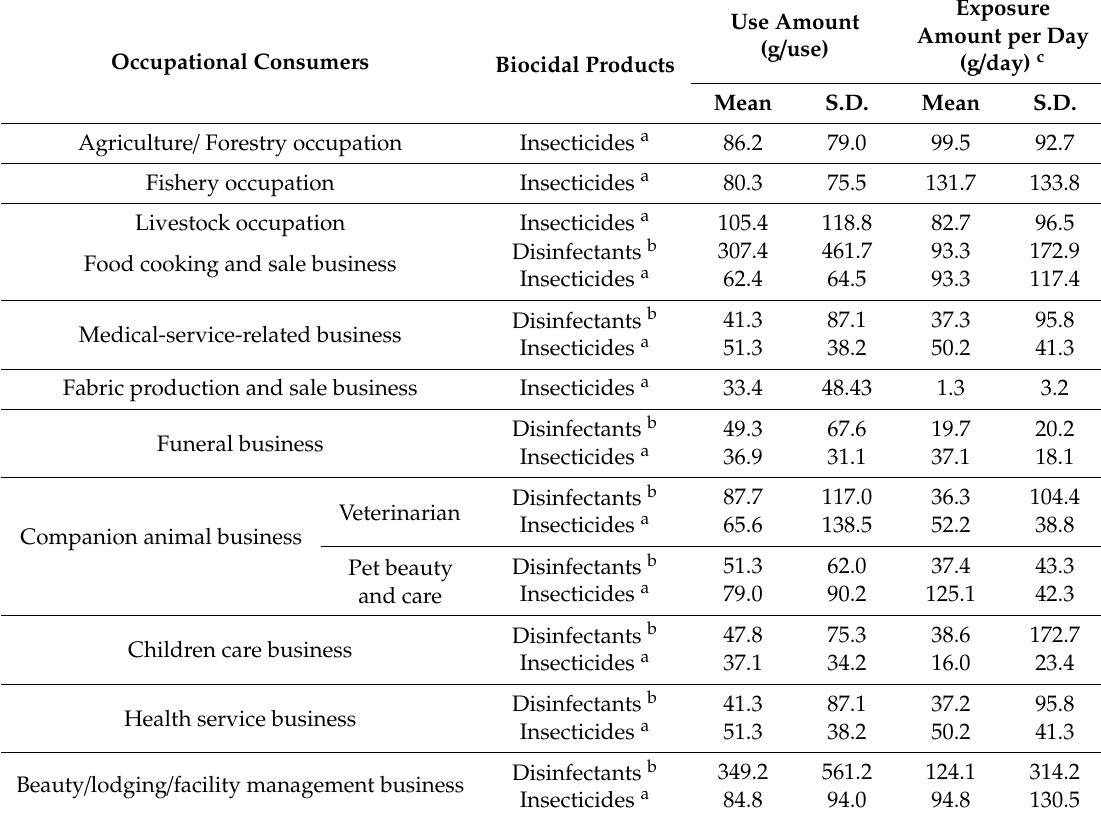
Table 4. Use amount and exposure amount of products used by occupational